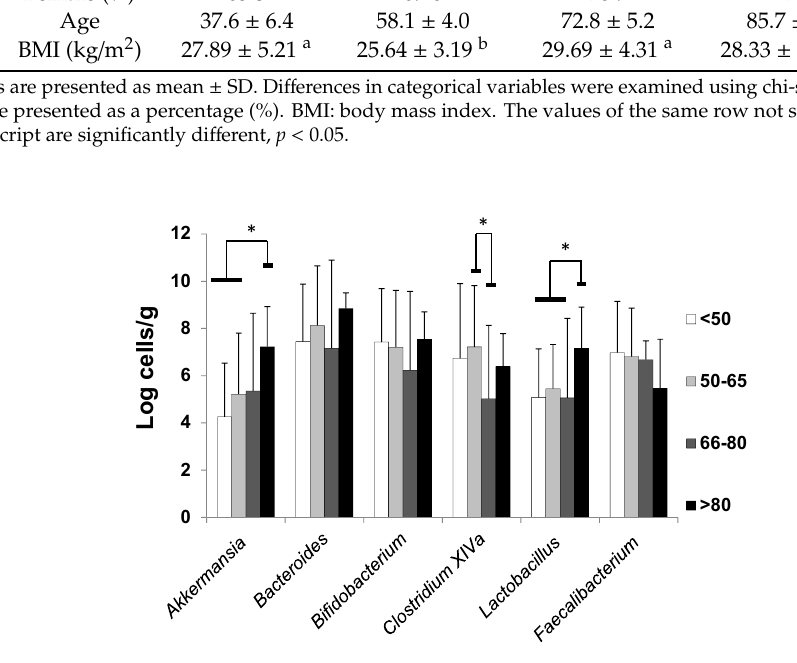
Table 1. General characteristics of subjects according to age groups.